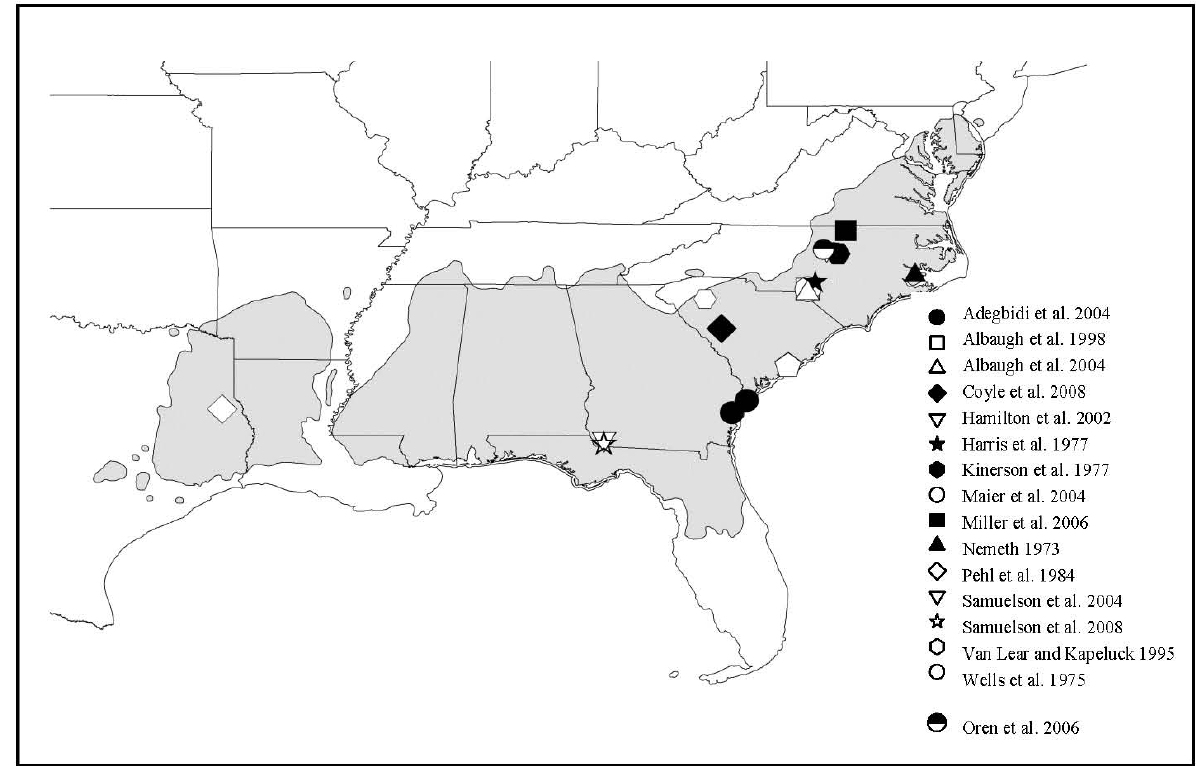
Figure 1. Location of data validation sources in the southeastern U.S. Shaded area indicates the natural range of loblolly pine. Sites with black-filled symbols were used for the allometric validation, sites with white symbols were used for the whole model validation, and sites with black and white circles were used for the NEP